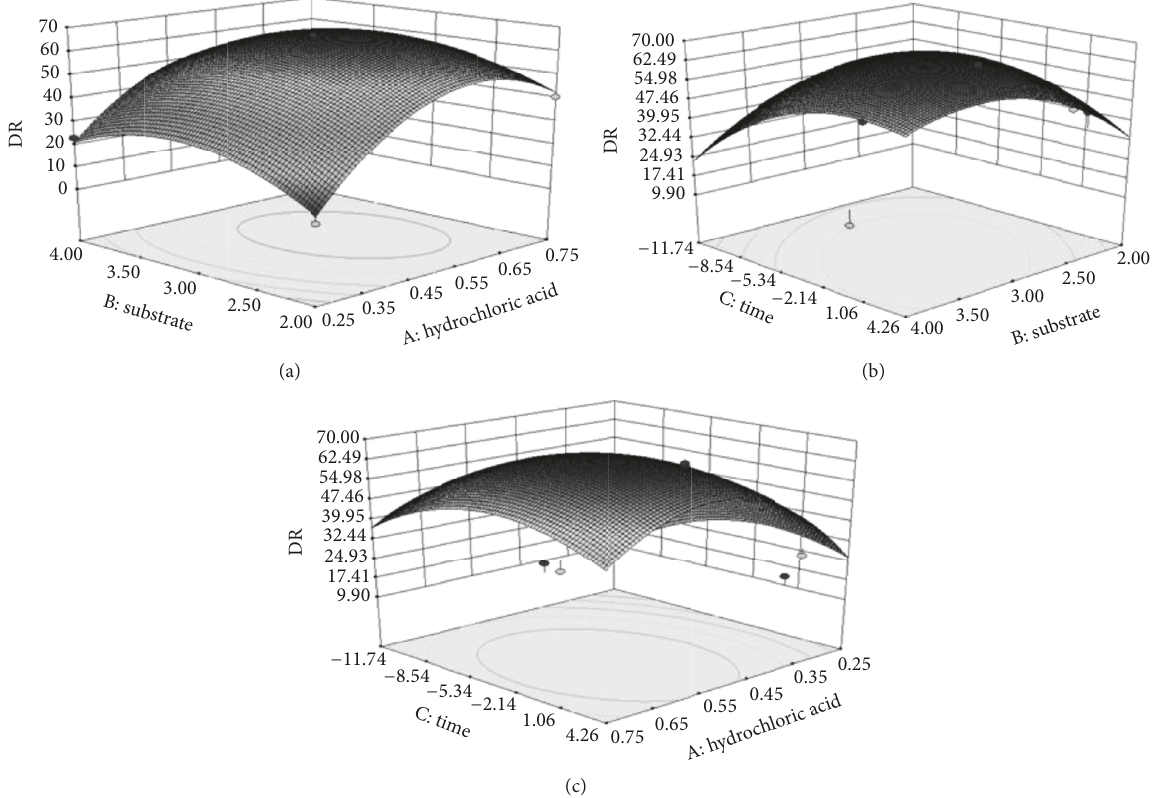
Figure 1: Response surface plot for acid degradation of polysaccharides on the effect of (a) varying hydrochloric acid concentration (mol/L) and substrate percentage (%), (b) varying time (h) and substrate percentage (%), and (c) varying time (h) and hydrochloric acid concentration